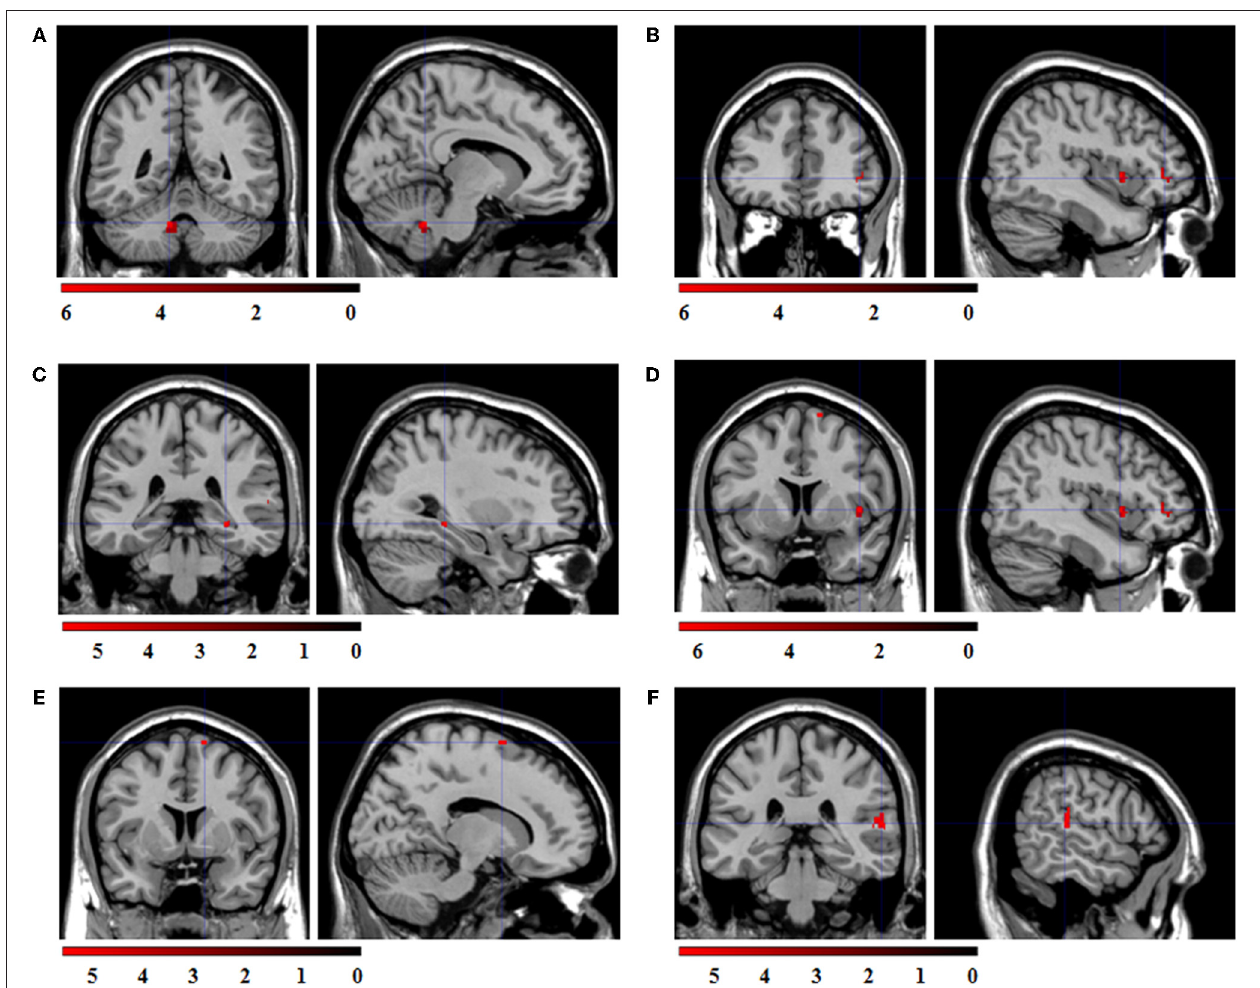
z = 0; t = 6 . 25; k = 25 voxel). (C) Significant co-activation in the right hippocampus, ( x = 30, y = − 34, z = − 6; t = 5 . 91; k = 8 voxel). (D) Significant co-activation in the right insula, ( x = 42, y = 8, z = 2; t = 6 . 54; k = 19 voxel). (E) Significant co-activation in the right supplementary motor area, ( x = 14, y = 6, z = 70; t = 5 . 26; k = 5 voxel). (F) Significant co-activation in the right superior temporal sulcus, ( x = 58, y = − 32, z = 12; t = 5 . 65; k = 35